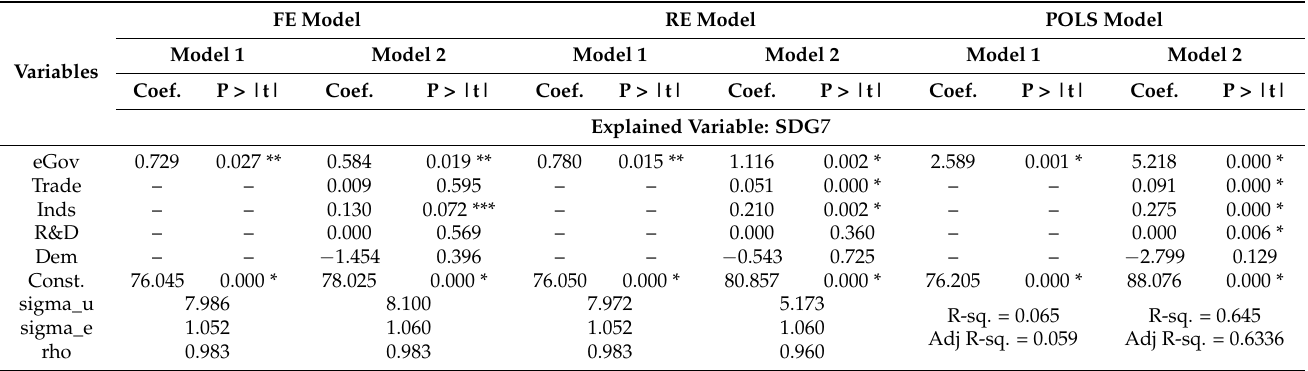
Table 5. The empirical results of e-governance impact on SDG7 affordable and clean energy using the FE, RE, and POLS